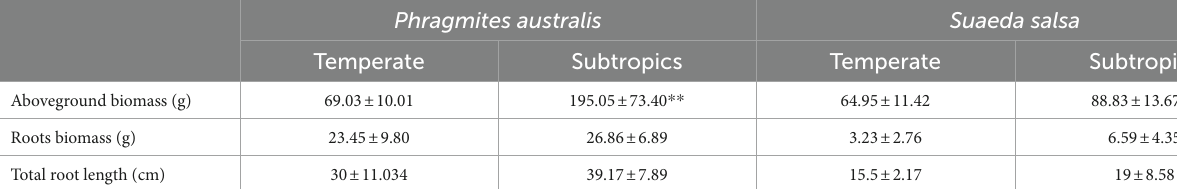
TABLE 2 Variation in plant functional traits.